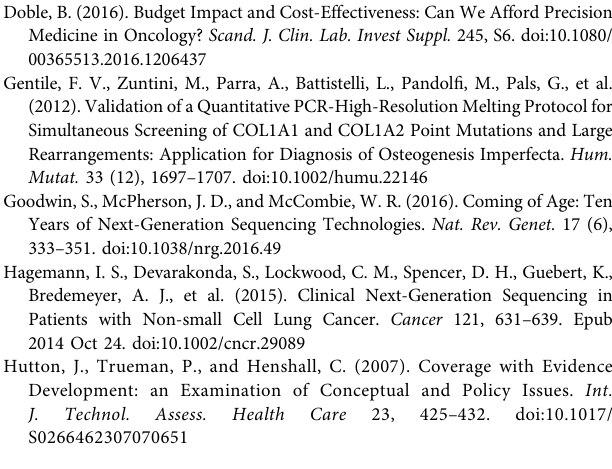
Supplementary Figure S1 | Details of “ Traditional ” and “ NGS-based ” molecular screening for MO disease. Supplementary Figure S2 | Details of “ Traditional ” and “ NGS-based ” molecular screening for OI